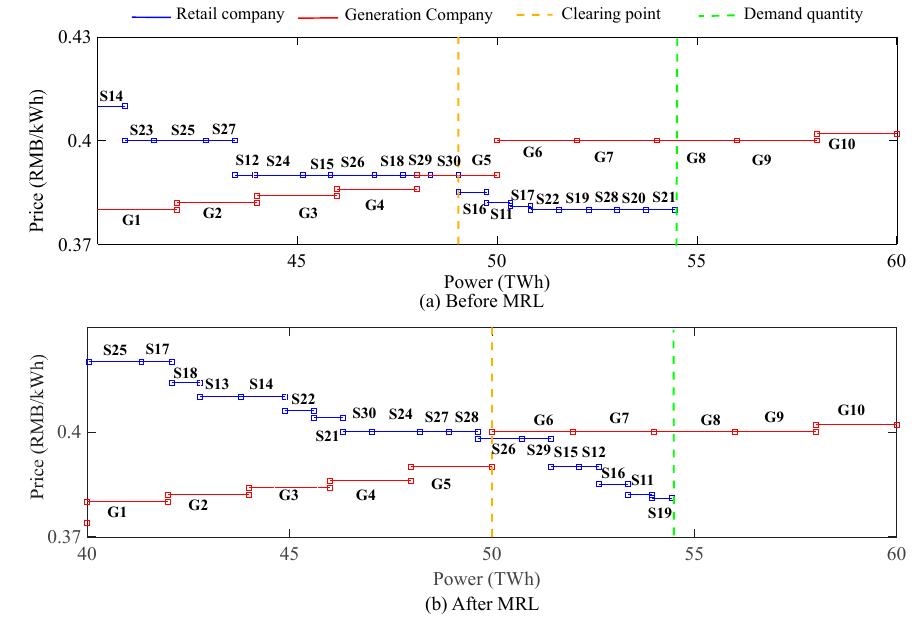
Figure 8. Market clearing results (1000 MRL rounds).